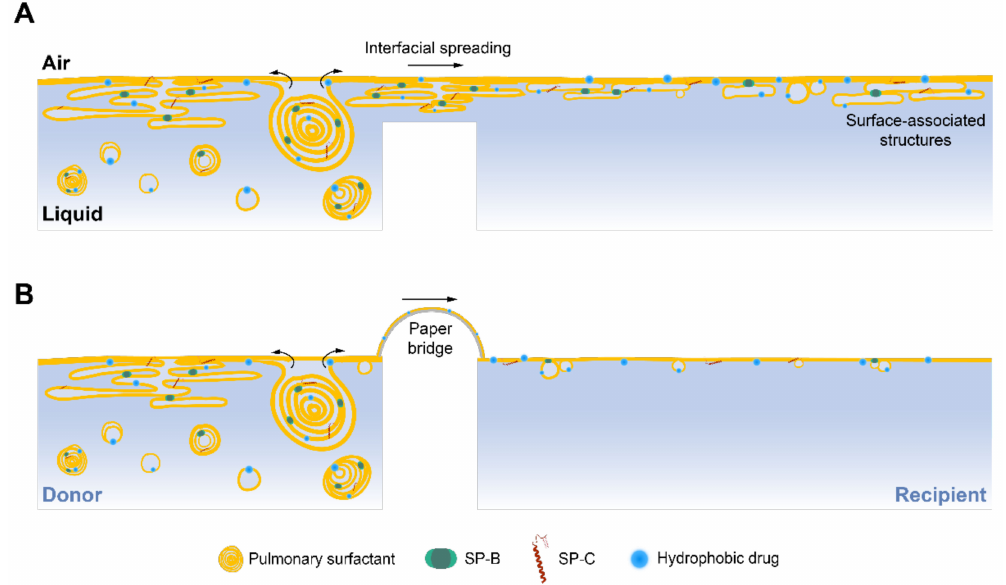
Figure 7. Proposed model of the interfacial spreading of surfactant structures in the double-balance setup. ( A ) Adsorption of a concentrated aqueous suspension of surfactant into the donor air–liquid interface forms surface-associated reservoirs, which can spread over the interface to the recipient compartment in the absence of the paper bridge. The spreading of surface-associated vesicles and multi-layered structures together with the interfacial film transport high amounts of lipids and the drug incorporated into them. ( B ) The structures associated with the surface formed upon surfactant adsorption are retained in the donor compartment in the presence of the bridge. Only the interfacial film and few associated vesicles could cross the bridge and reach the recipient interface, transporting less material. The drawings do not intend to represent the real scale of the system nor the